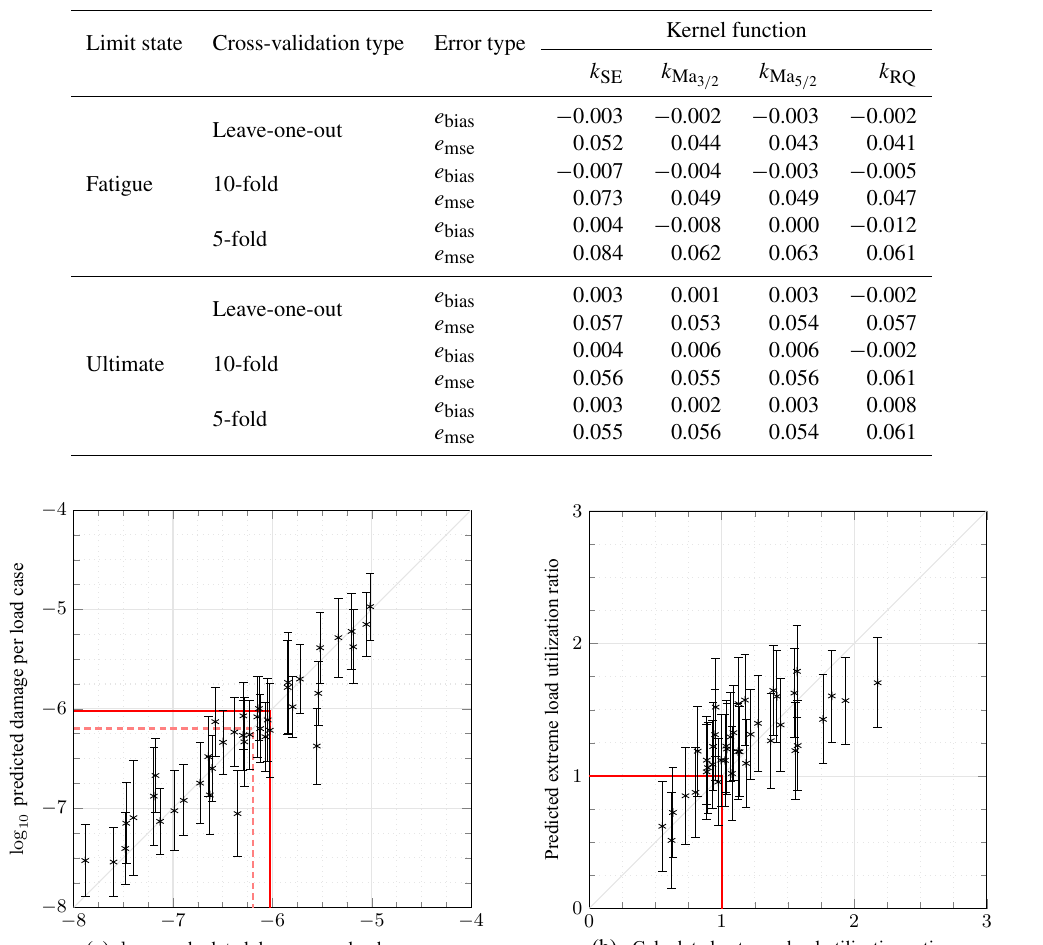
Table 4. Cross-validation results for kernel functions applied to fatigue and ultimate limit state outputs, each case with ideal hyperparameters obtained by maximum likelihood estimation.